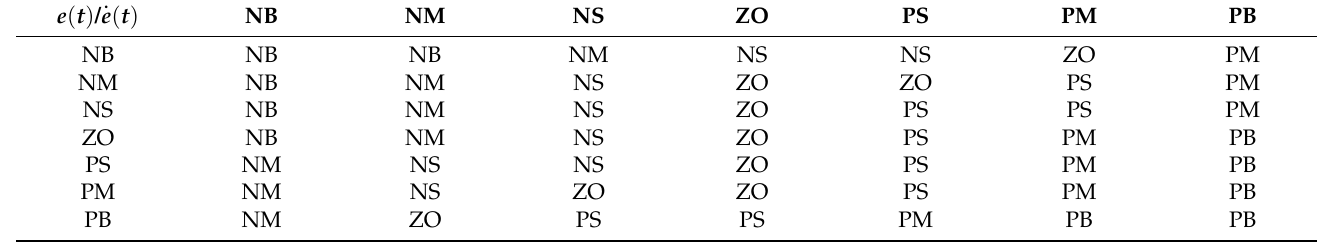
Table 1. Fuzzy control rules for AUV.